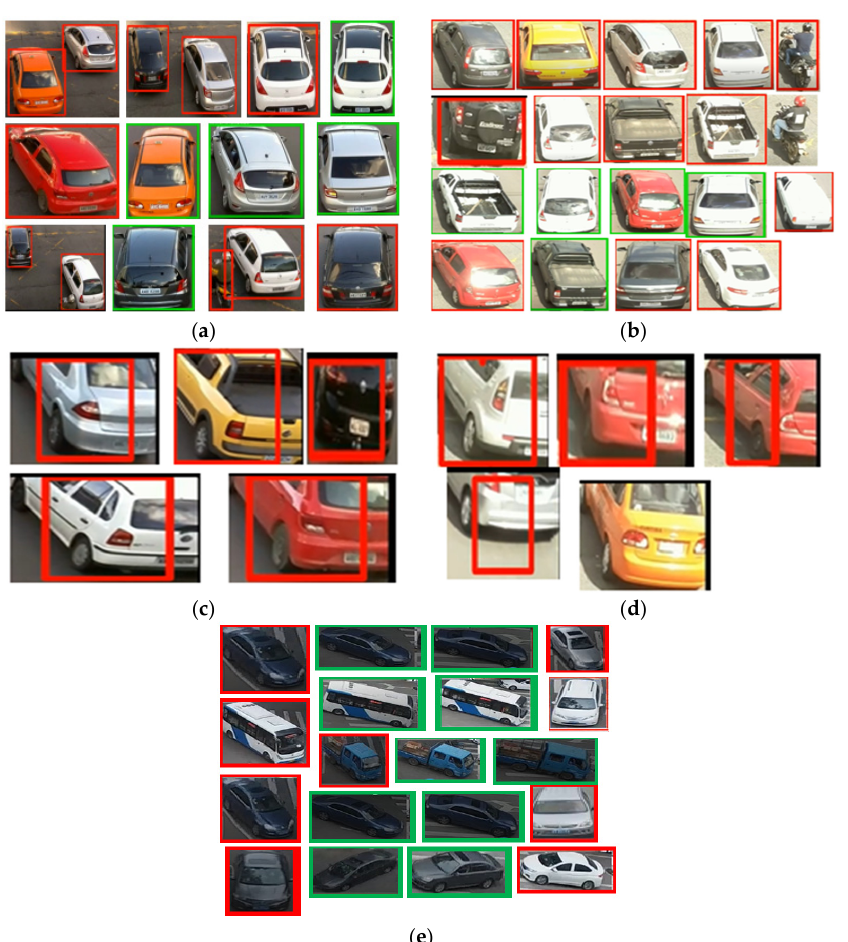
Figure 4. To visualize the detector and the proposed TSDCNN’s overall performance quality on vehicle matching rates across non-overlapping cameras with multiple angle views: ( a ) shows vehicles detection and matching under normal environmental conditions; ( b ) shows vehicles detection and matching under extreme illumination variations conditions. Then ( c , d ) are the algorithms’ poor detection quality and matching limitations under normal and extreme illumination variations conditions, respectively. Then ( e ) illustrates vehicle detection and matching under the extreme rotation variations. The red boxes around vehicles indicate the first detections, while the green boxes denotes the matches for the detected vehicle across the non-overlapping cameras.